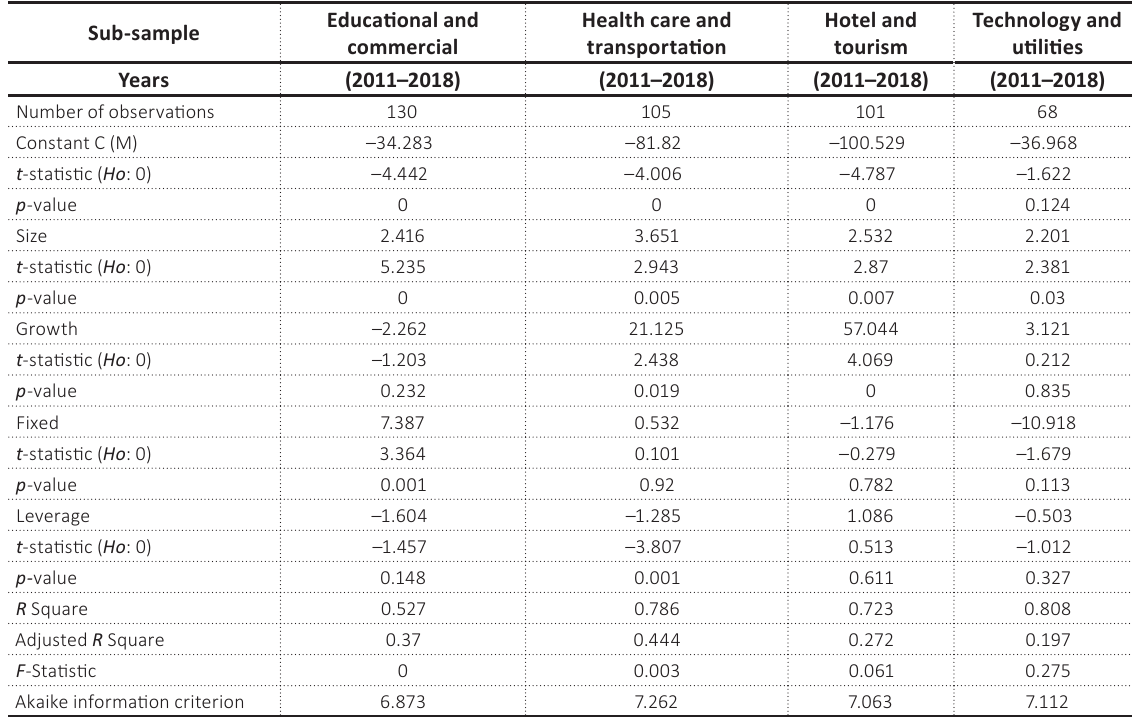
Table 9 provides the regression analysis results for the services sector sub-samples. Table 9. Regression analysis for the services